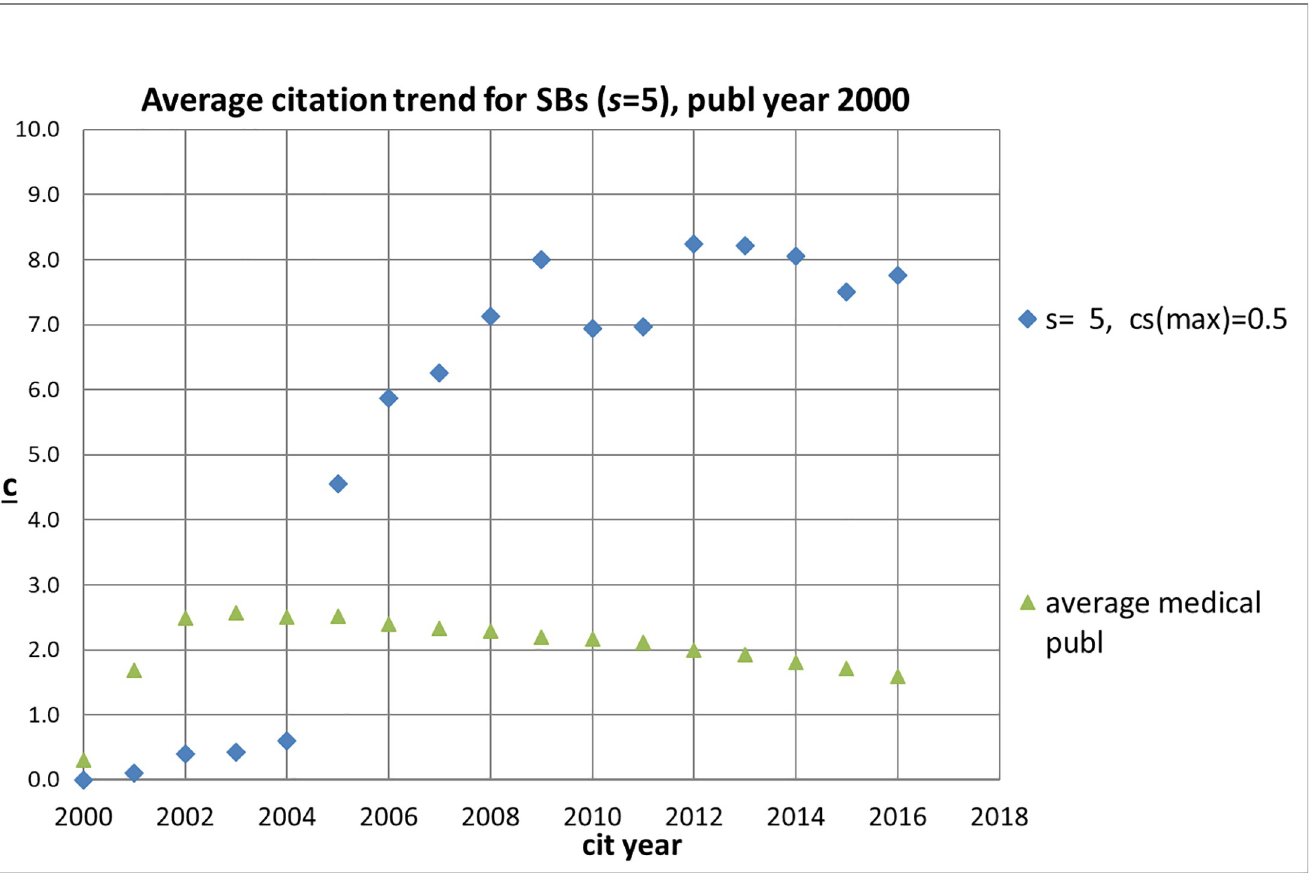
Fig 4. Average citation (c) trend in the period 2000–2016 for SBs with s = 5 and c s (max) = 0.5 as well an average medical publication with publication year